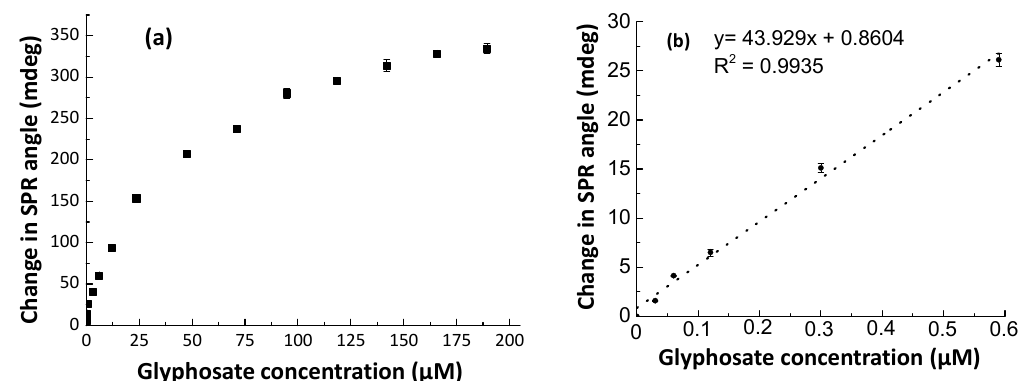
Figure 11. Glyphosate sorption onto CS / ZnO SPR sensors at pH 5.5: ( a ) full sorption isotherm of glyphosate; ( b ) calibration curve in the glyphosate concentration ranges between 0.03 and 0.59 µ M.